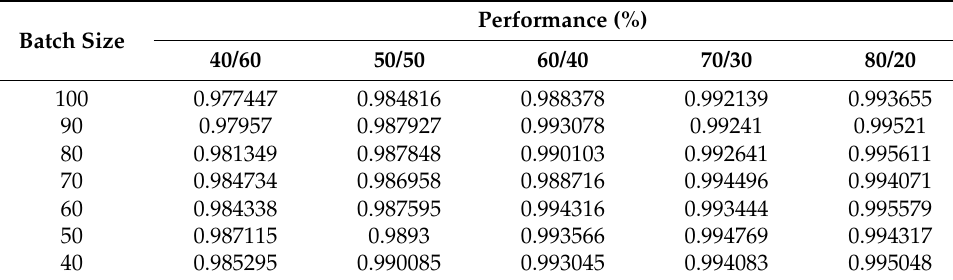
Table 2. Performance on various split ratios.